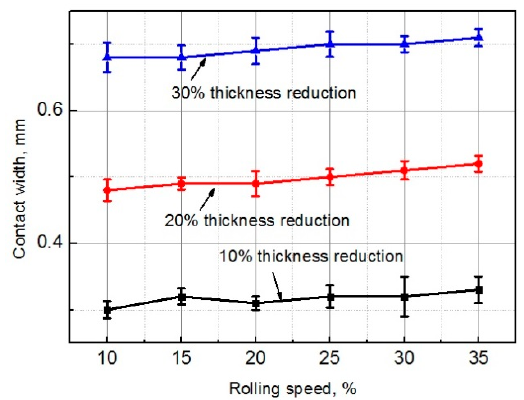
Figure 13. Contact width with rolling reduction and rolling speed (1 mm in diameter).